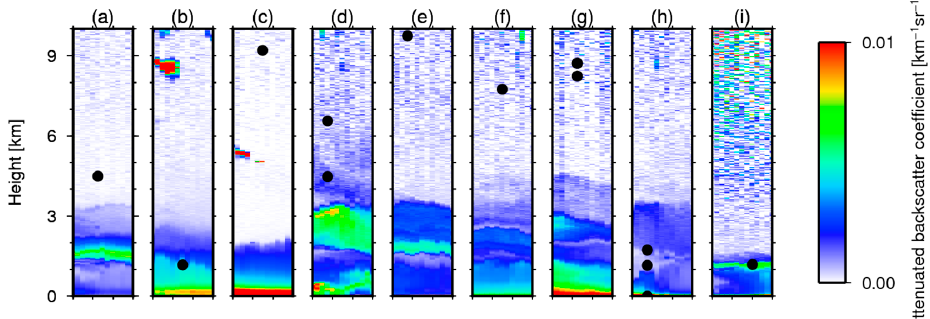
Figure 2. Temporal and vertical distribution of attenuated backscatter coefficient at 1064 nm from lidar observations and the detected layer height from the slicing method for the collocated data (black circle). Data were obtained (a) at Osaka on 14 March 2010, (b) on 20 March 2010, (c) on 2 May 2011, (d) at Chiba on 6 April 2010, (e) on 6 May 2010, (f) at Hedo 1 May 2010, (g) at Matsue on 4 May 2010, (h) at Tokyo on 6 April 2010, and (i) at Seoul on 17 January 2010. The x-axis ranges are 3:00 to 6:00 (UTC) for all cases.